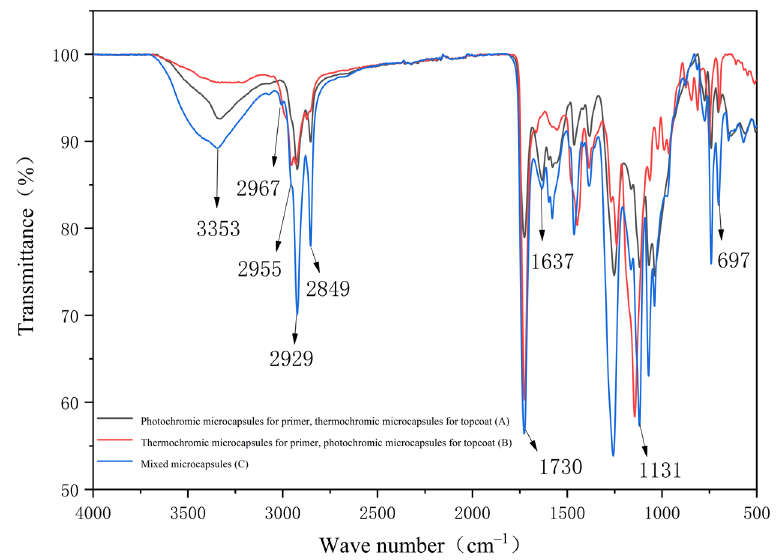
Figure 6. Infrared spectra of coatings with different coating processes.